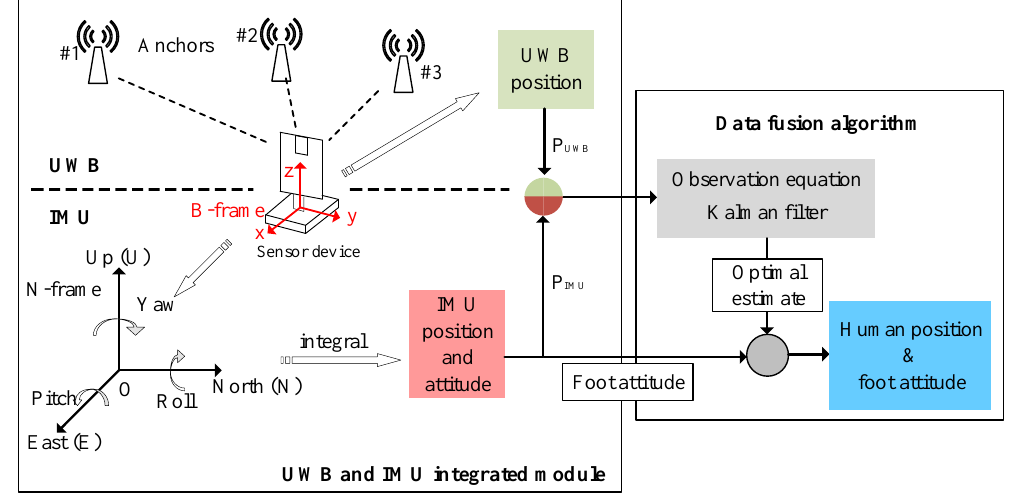
Figure 8. Synchronized processing for the UWB and IMU signals.